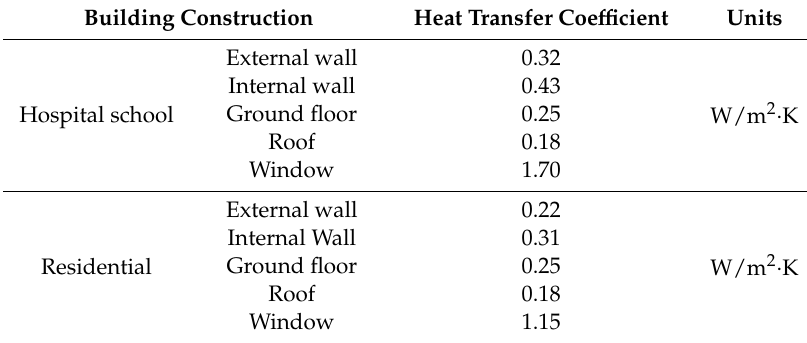
Table 1. Thermal transmittance [13].